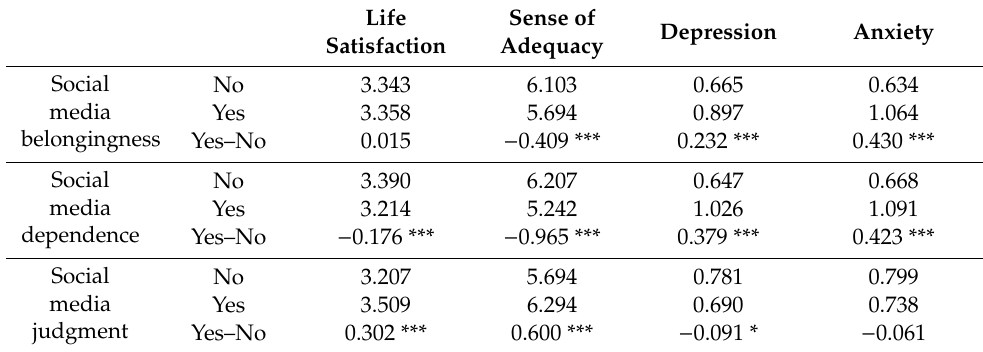
Table 2. Mean comparison of mental health indicators on social media